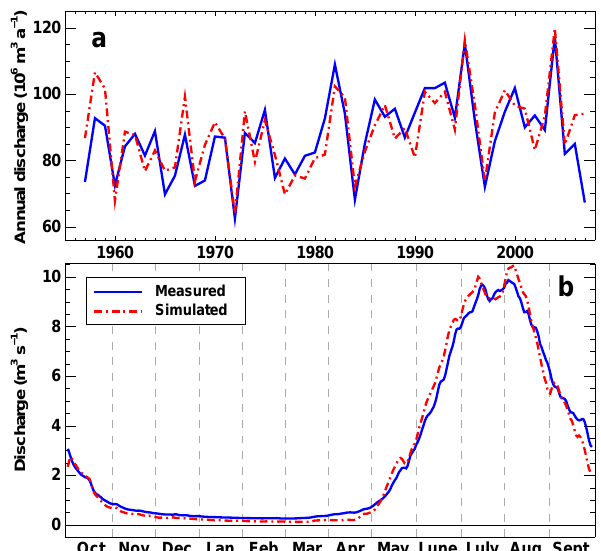
Fig. 4. Validation of discharge from the Rhonegletscher catchment calculated using GERM using measurements at Gletsch. (a) Annual runoff volume, and (b) stacked daily runoff hydrographs for the period 1957-2006.